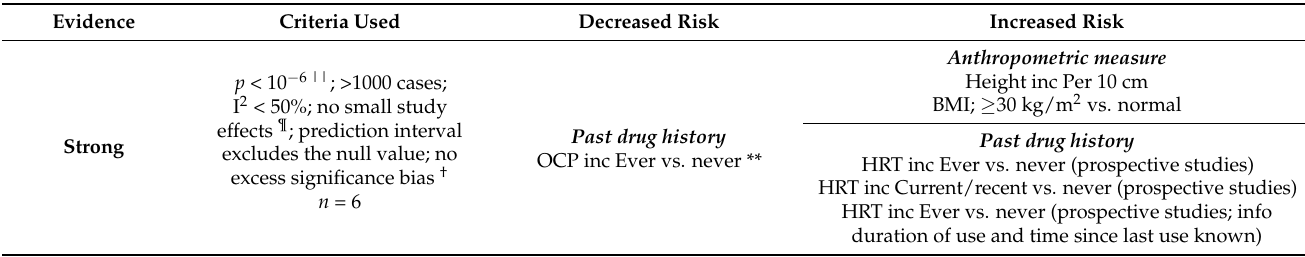
Table 1. Summary of evidence grading for meta-analysis of risk factors associated with ovarian cancer incidence or mortality–cohort studies only